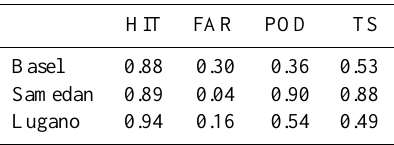
Table 5. Statistical indices for all there sites including daily observations of SCD MODIS and SCD in situ from 1 October 2000 to 30 September 2010 based on confusion matrices (hit rate, HIT; false alarm rate, FAR; probability of detection, POD; threat score,